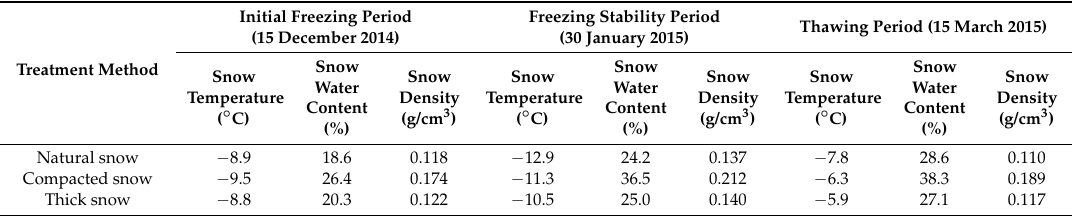
Table 2. Physical parameters of snow